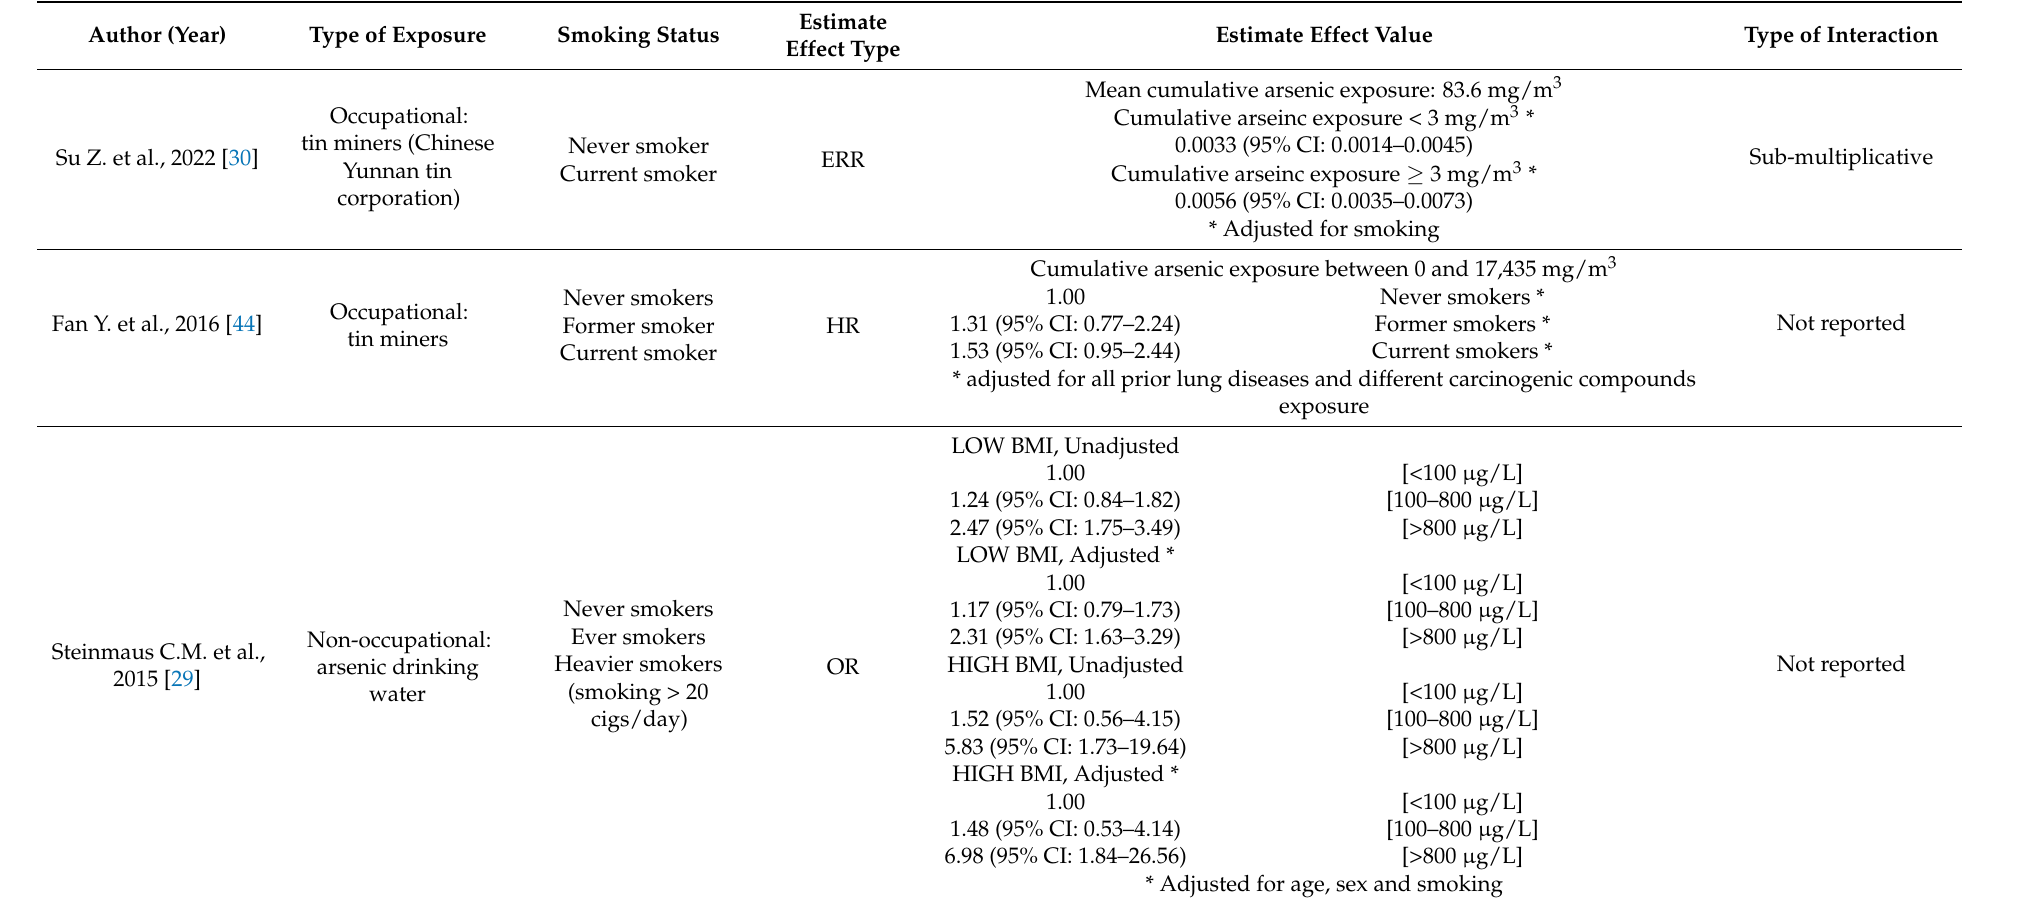
Table 2. Quantitative analysis of the included